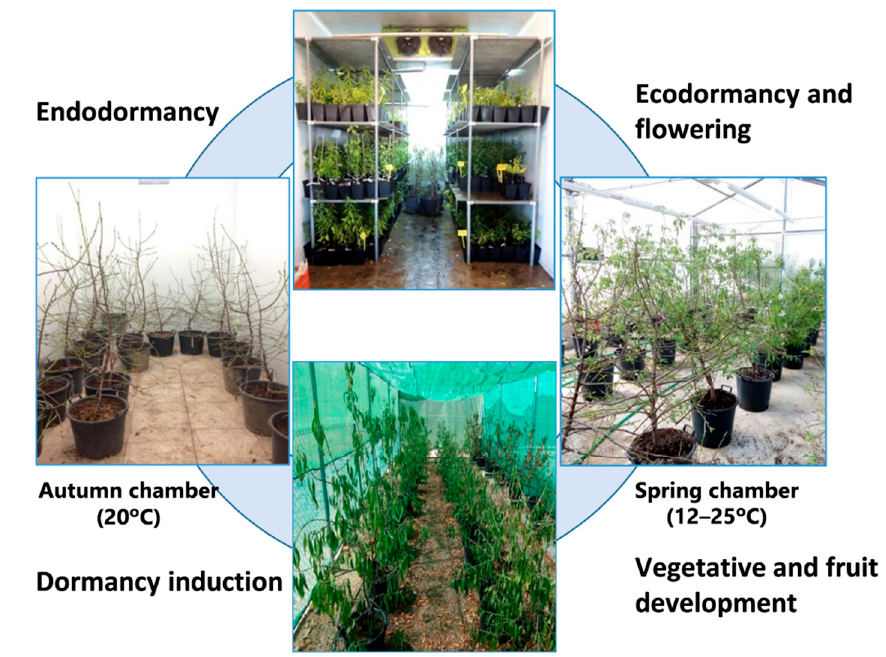
di ff erent Figure 1. The experimental design for flowering time modulation by temperature control in different chambers.